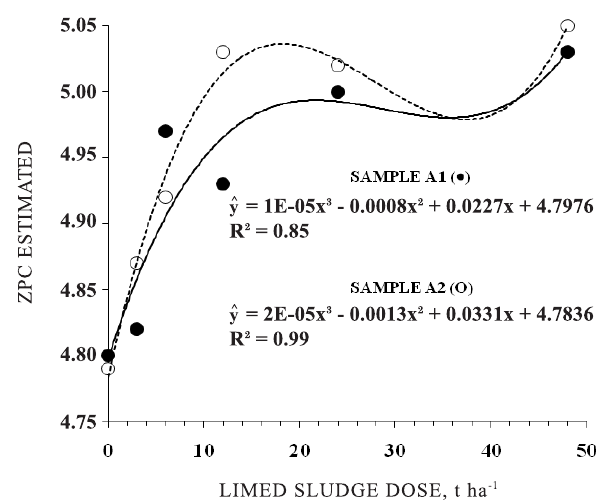
2. Relationship between the doses of limed sludge (50 %) and the estimated point of zero charge (PZC ) for soil samples A1 (very estimated clayey texture) and A2 (medium texture), used in this